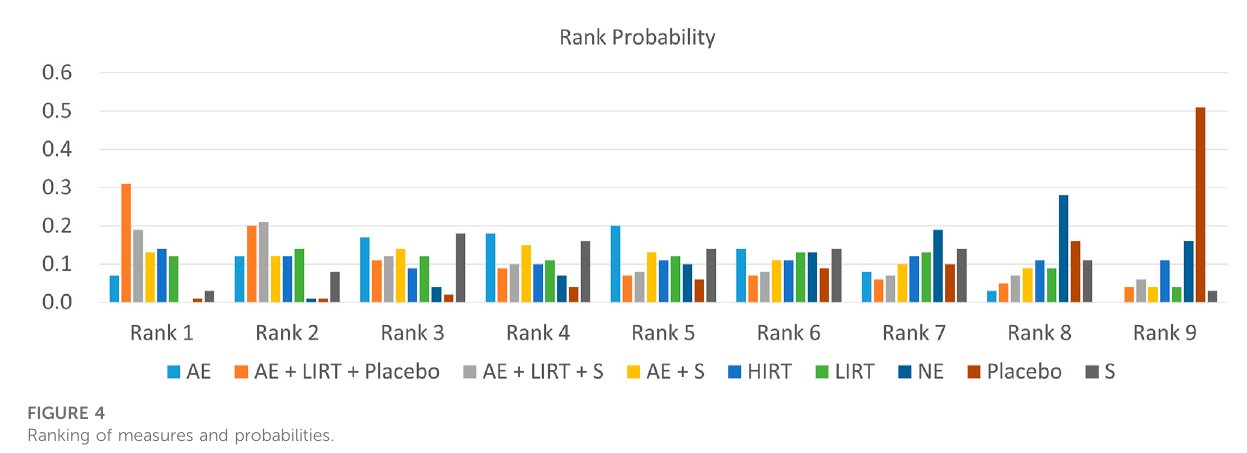
FIGURE 4 Ranking of measures and probabilities.